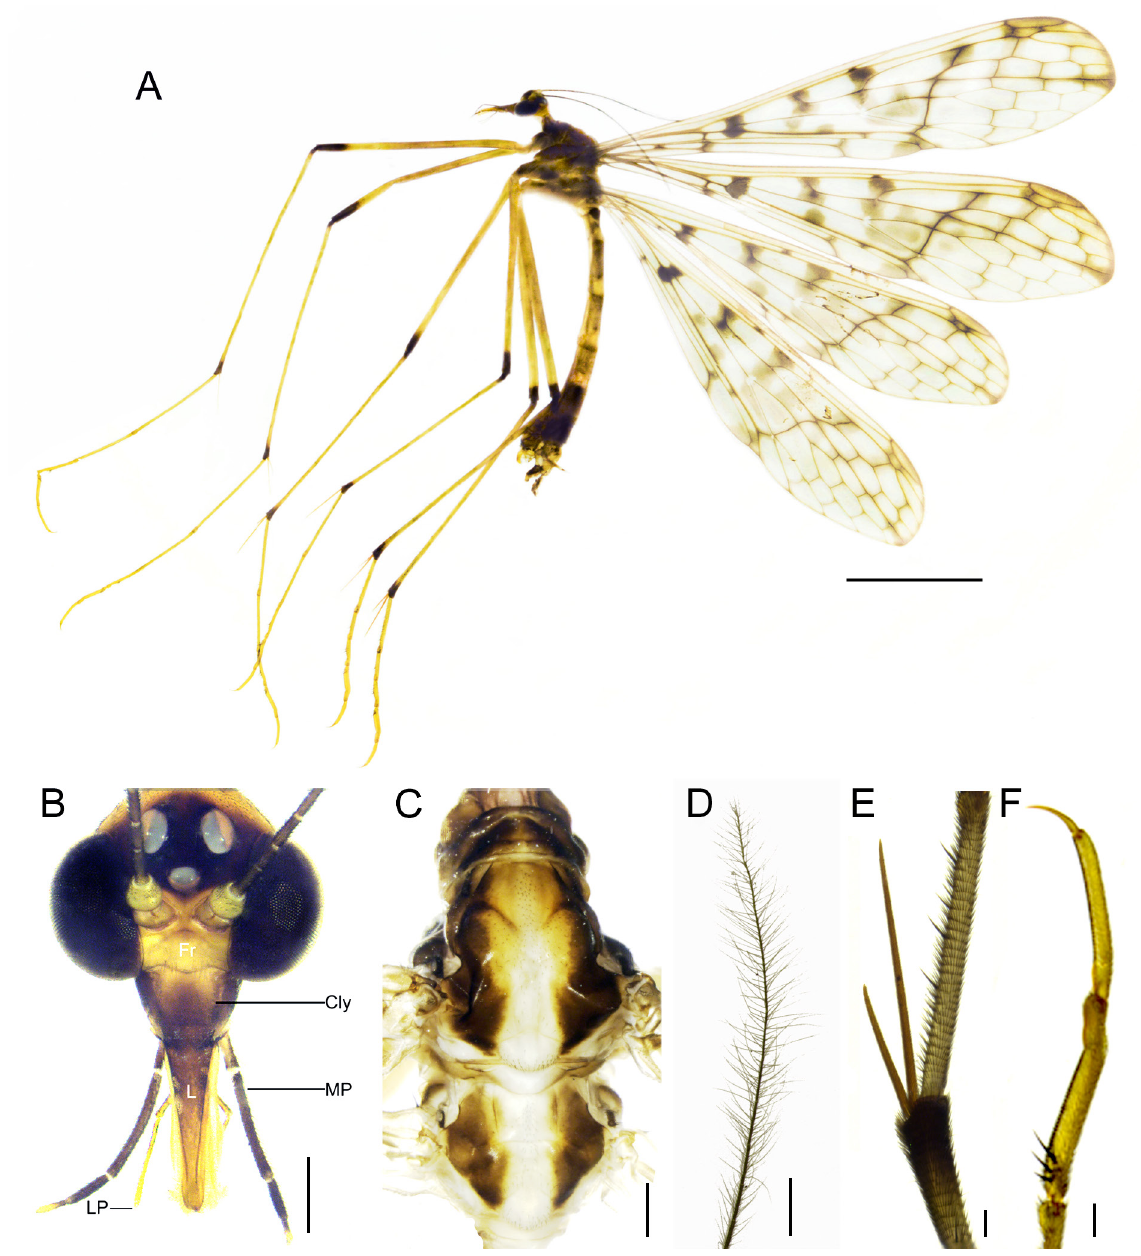
Fig. 5. Bittacus leigongshanicus sp. nov., ♂, holotype (NWAU). A . Habitus in lateral view. B . Head in frontal view. C . Thorax in dorsal view. D . Flagellum of antenna. E . Tibia with two apical tibial spurs of left foreleg. F . Tarsomeres IV, V and claw of left foreleg. Abbreviations: see Material and methods. Scale bars: A = 5.0 mm; B–D = 0.5 mm; E–F = 0.2